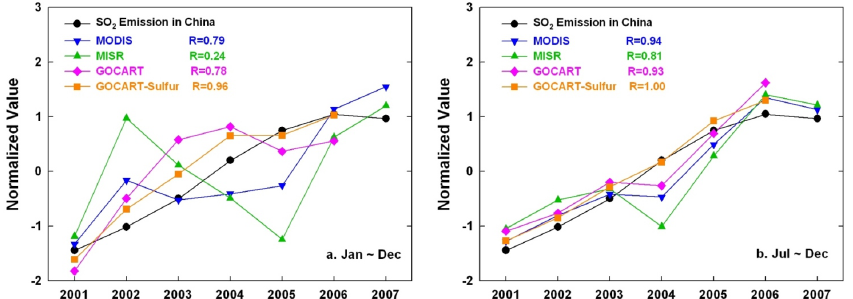
Fig. 16. Three-year central moving average values of normalized China SO 2 emission, MODIS AOD, MISR AOD, GOCART AOD, and the sulfur portion of GOCART AOD over East Asia. Values are averaged (a) from January to December and (b) from July to December of each year. R values shown are the correlation coefficients of each dataset with SO 2 emission in